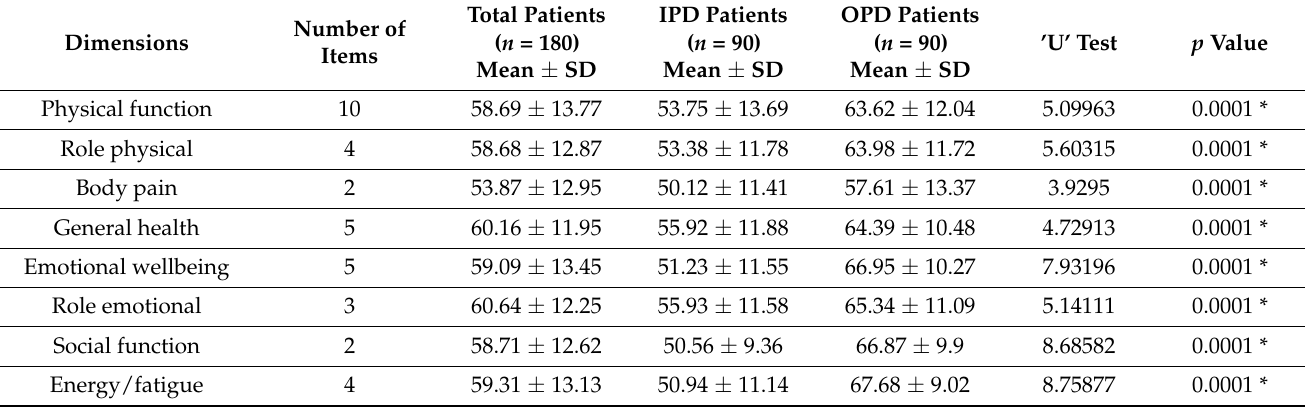
Table 3. KDQOL-SF scores of the patients ( n =